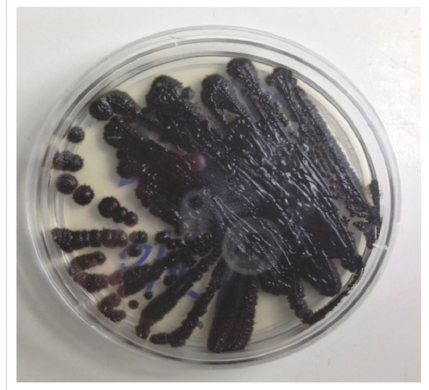
Figure 1: Exophiala dermatitidis growing on Sabouraud Dextrose agar at 37 degrees